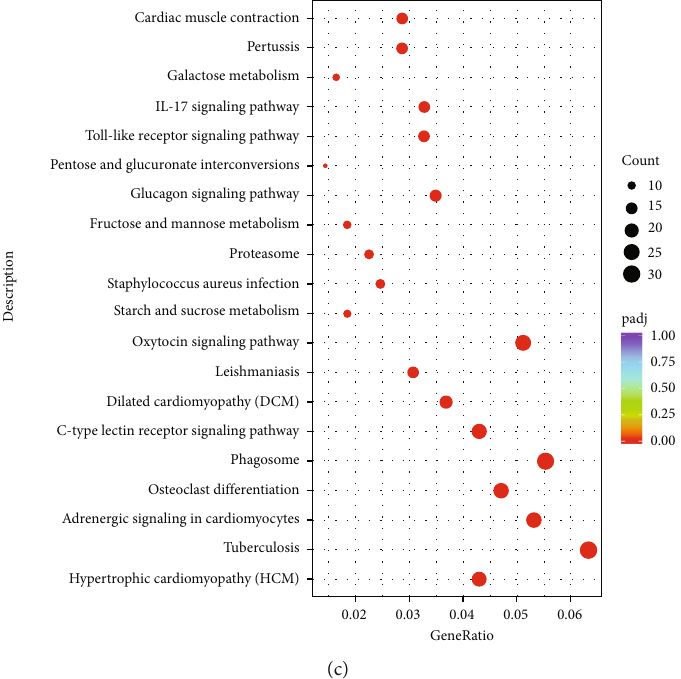
Figure 2: Functional analyses of these DEmRNAs. (a) The signi fi cantly enriched gene ontology (GO) terms of these DEmRNAs in molecular function, cellular component, and biological process. (b) The signi fi cantly enriched Kyoto Encyclopedia of Genes and Genomes (KEGG) of the downregulated genes. (c) The signi fi cantly enriched KEGG pathways of the upregulated